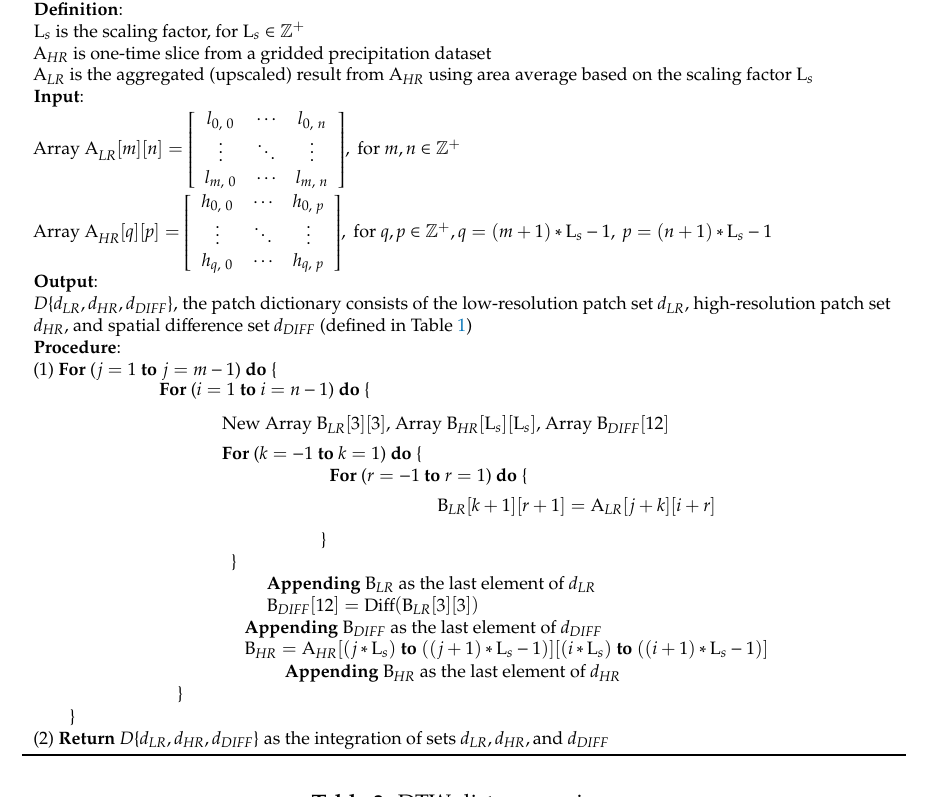
Table 3. DTW distance